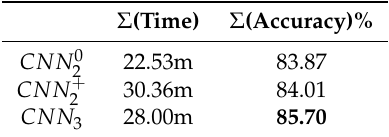
Table 3. Table summarizing the results of the multiple occupancy